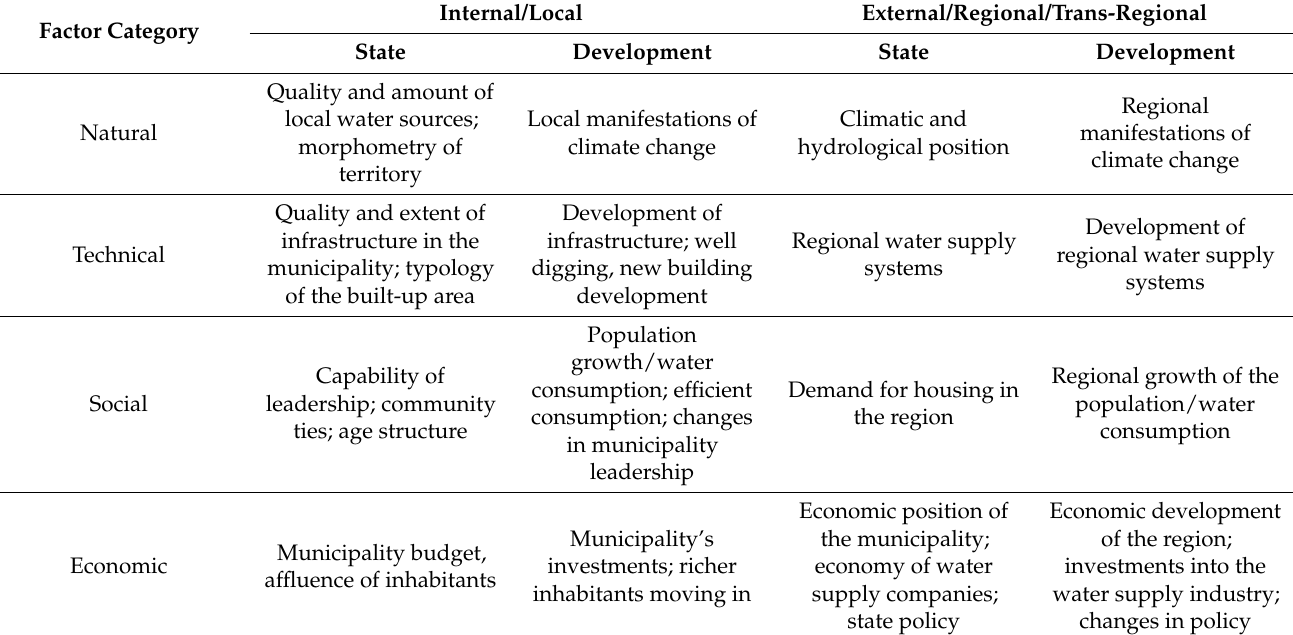
Table 1. Factors influencing the state and development of drinking water